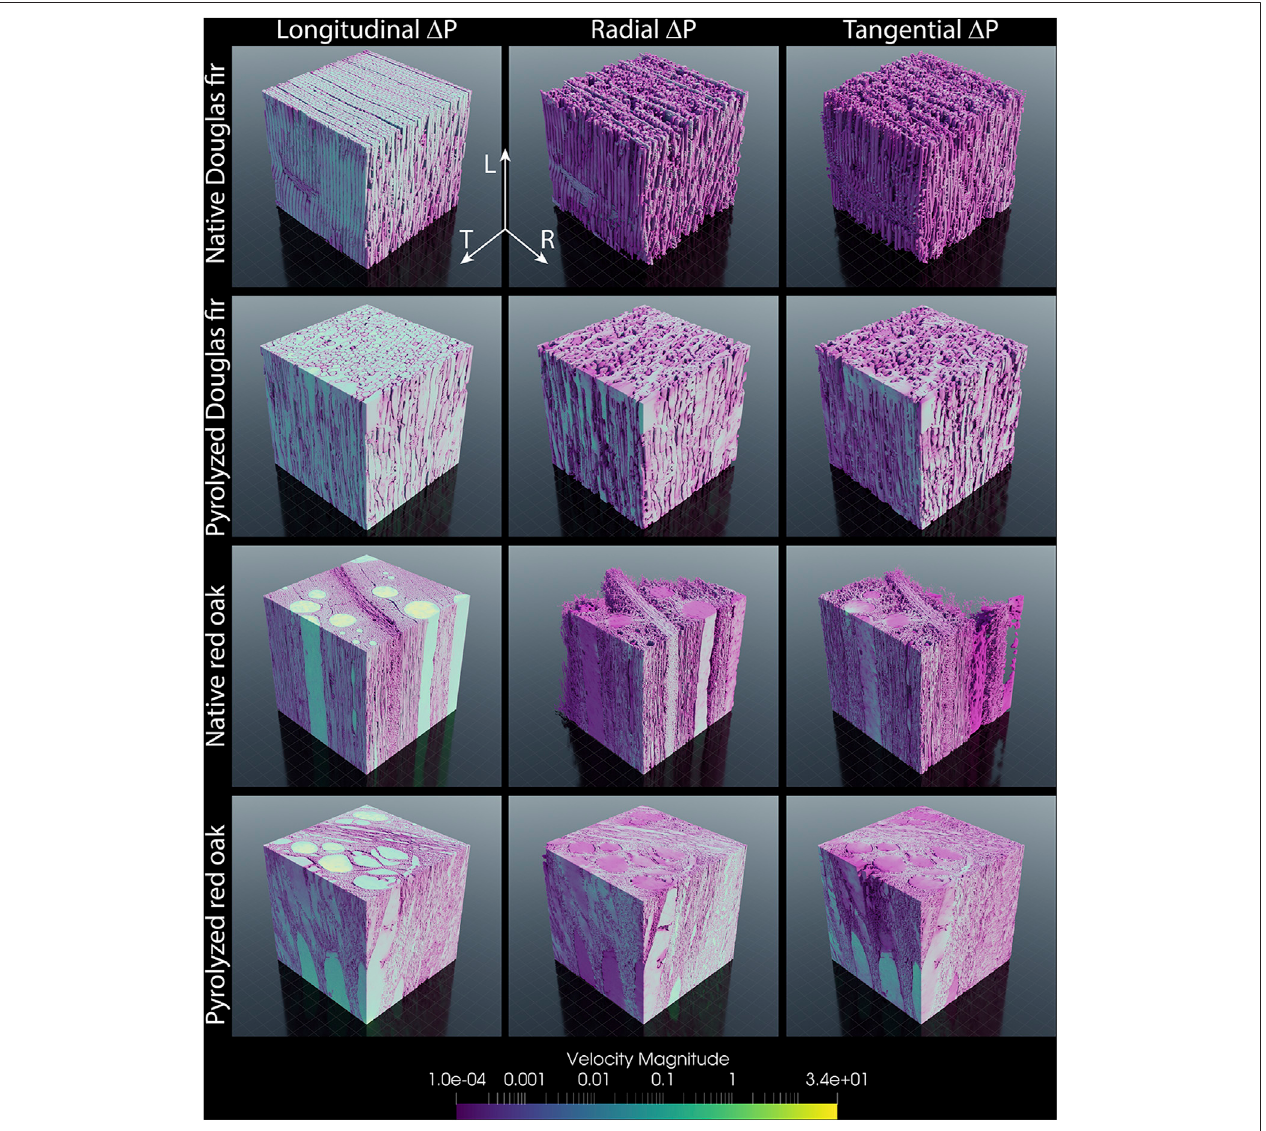
FIGURE 6 | Visualization of permeability simulations at steady state for native and pyrolyzed Douglas fi r and red oak XCT sub-volumes. Pressure gradients were applied to only one of the longitudinal, radial, and tangential directions in each case. Velocity magnitudes less than 10 − 4 are below the visualization cutoff, hence the partial renditions for the native red oak simulations in the radial and tangential